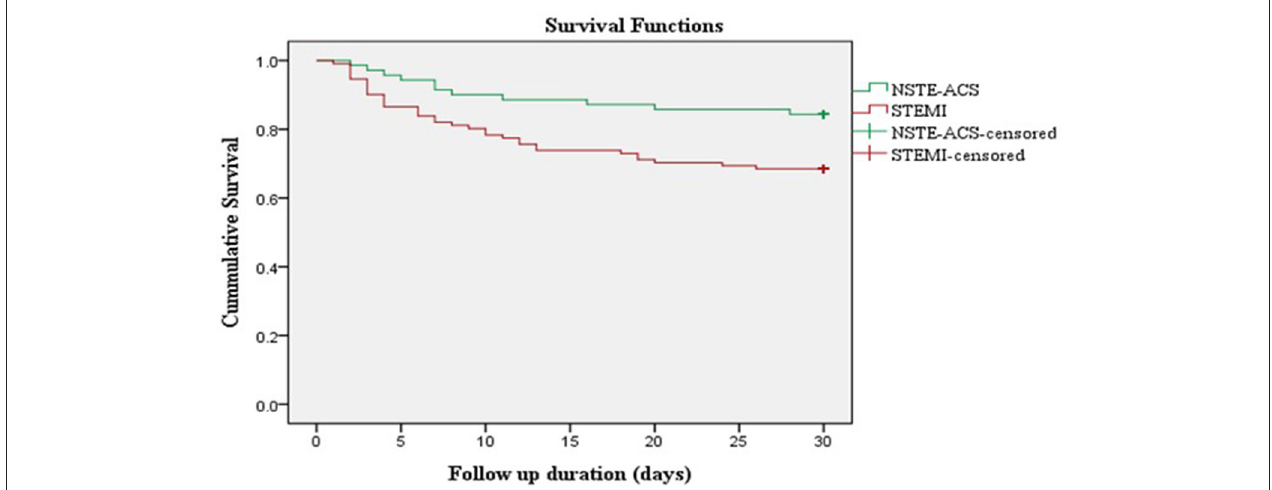
FIGURE 2 | Kaplan Meier survival curve of ACS patients stratified according to ACS subtypes. NSTE-ACS, non-ST-elevation acute coronary syndrome; STEMI, ST-elevation myocardial infarction.